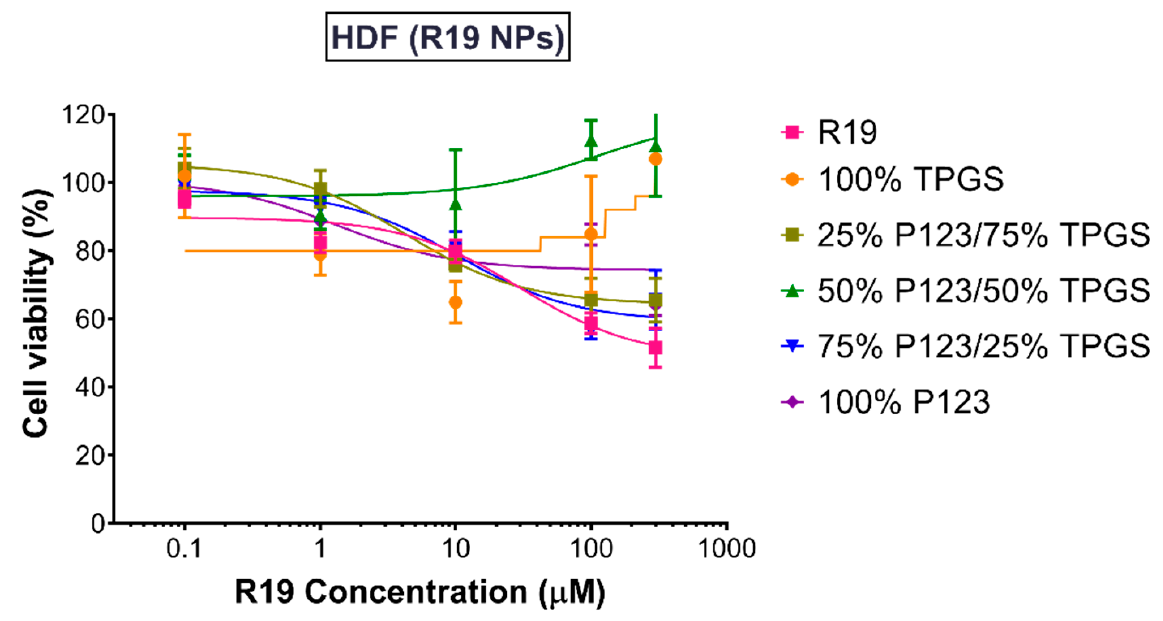
Figure 10. Percentage viability of HDF treated with R19 and R19-loaded NPs for 48 h ( n = 5). 3.5. Mitochondrial Membrane Potential Assay of R19-Treated